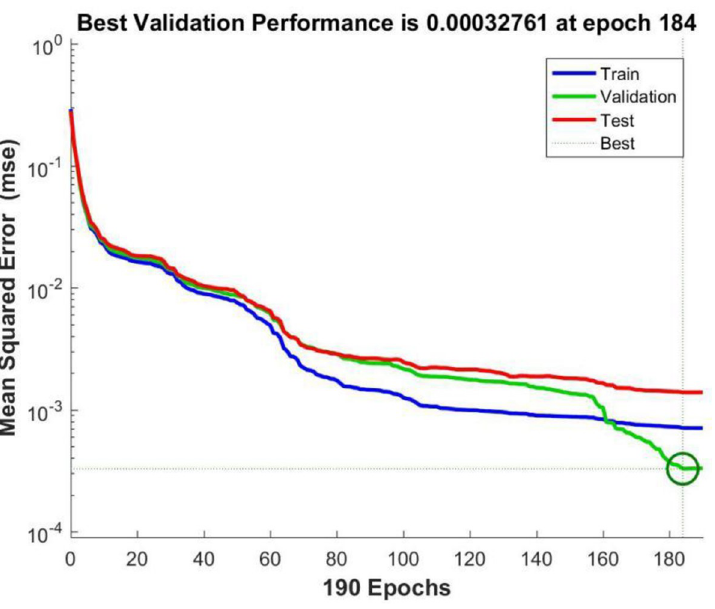
Fig 8. Trainscg performance